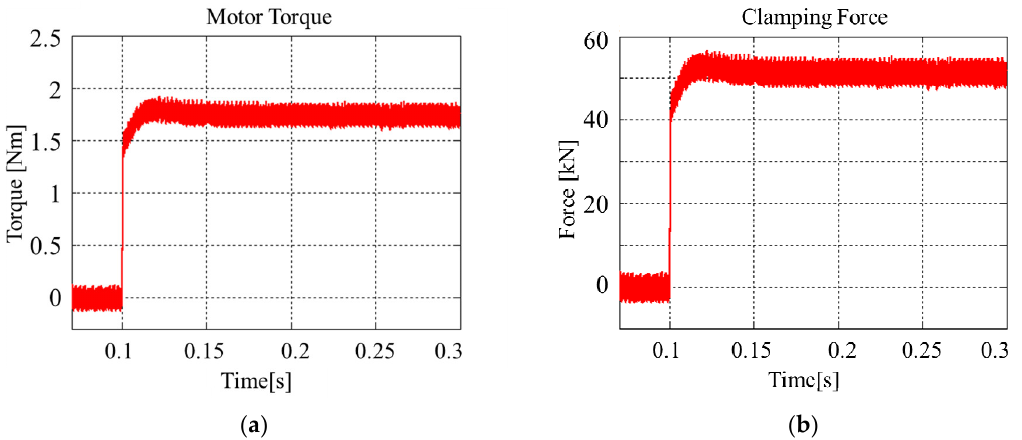
Figure 5. Simulation results for current control: ( a ) torque output from SPMSM; ( b ) clamping force from caliper.